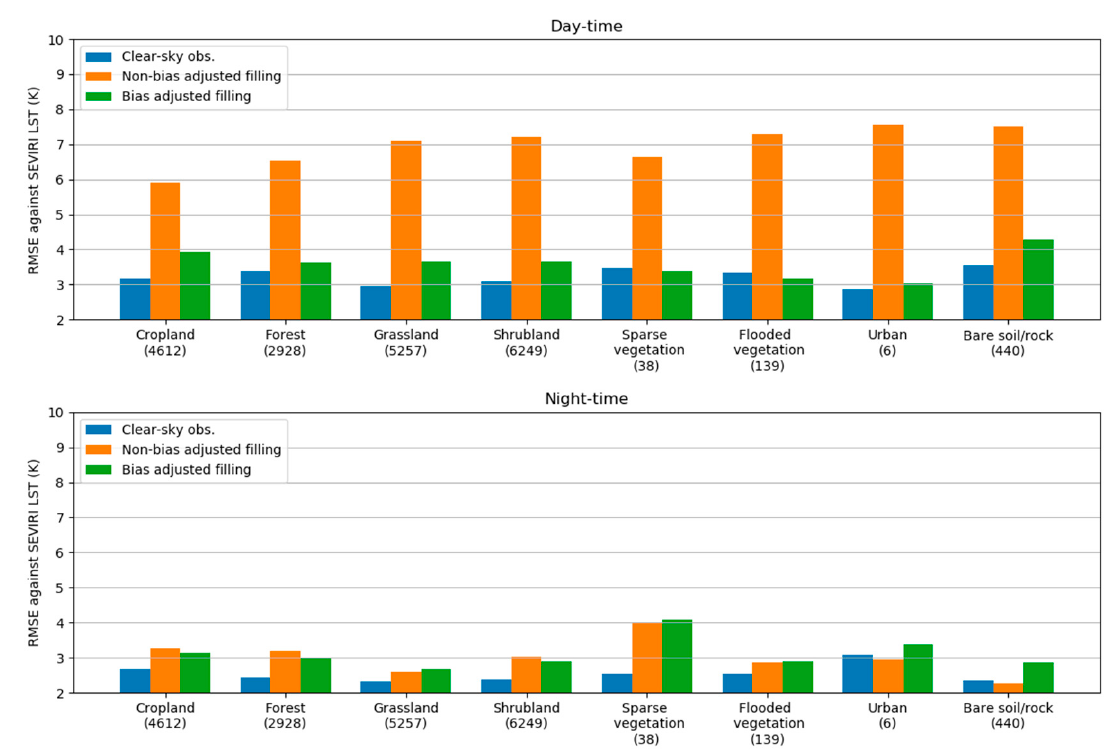
Figure 9. RMSE of MODIS Clear, MODIS STDF, and MODIS PMBC against SEVIRI LST for different land cover types in the day ( top ) and in the night ( bottom ). Numbers in the brackets denote pixel numbers of that specific land cover type.